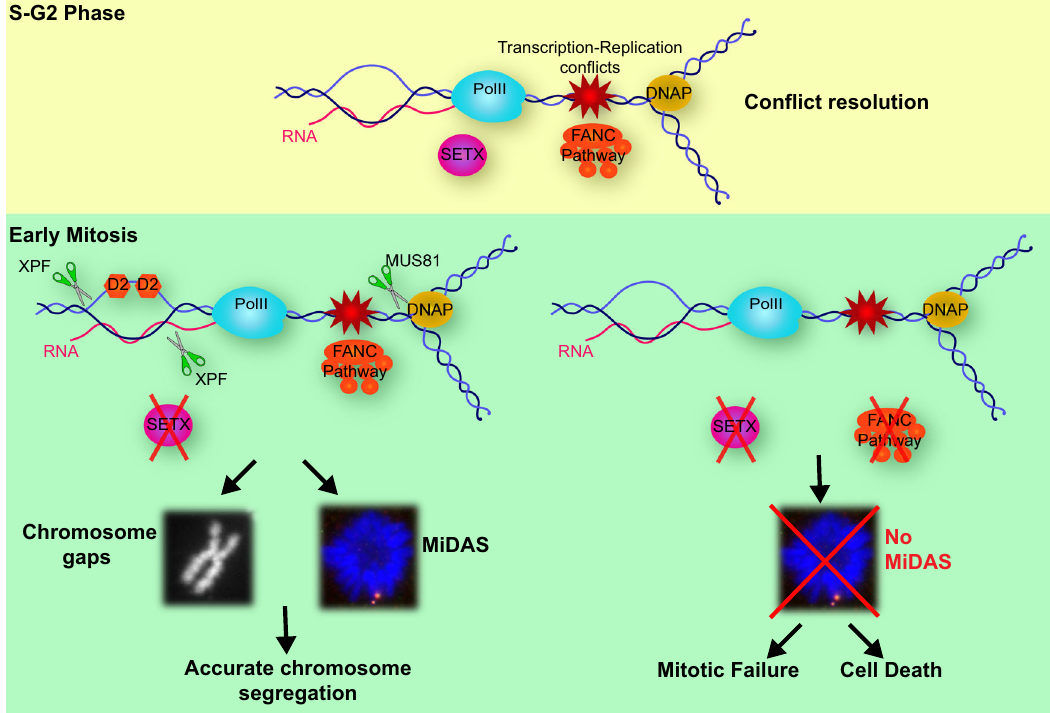
Fig. 6 Model for FANCD2-mediated mitotic rescue of transcription-associated RS in SETX de fi cient cells. SETX and proteins in the FANC pathway constitute partially redundant pathways to resolve transcription-replication con fl icts and R-loops. In absence of SETX, transcription-dependent R-loops persist in mitosis especially at loci such as long genes at common fragile sites that replicate in late S-G2 phase. By early mitosis, FANCD2 (depicted as D2), which is able to bind R-loop structures in complex with FANCI 50 , is recruited to these loci, visible as gaps on mitotic chromosomes. FANCD2 promotes MUS81 and XPF-dependent cleavages and rescue of un-replicated DNA structures by mitotic DNA synthesis (MiDAS), which allows sister-chromatid disjunction and faithful chromosome segregation. In absence of FANC pathway, these structures remain unresolved and un-replicated DNA impairs chromosome segregation causing mitotic failure and cell